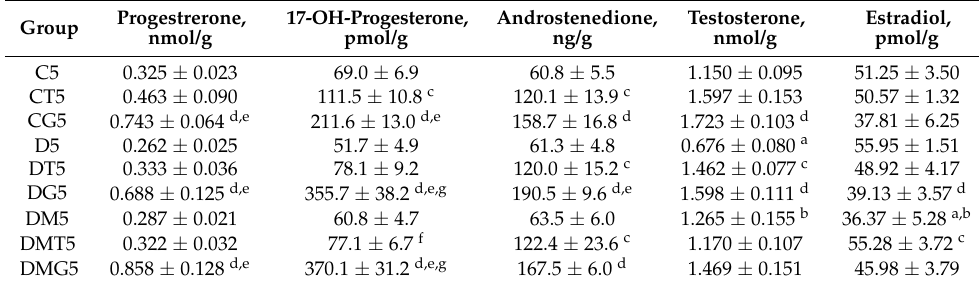
Table 5. The influence of five-day treatment with hCG and TP3 on the testicular levels of testos- terone, estradiol and their precursors in the control and diabetic rats, and the effect of five-week metformin